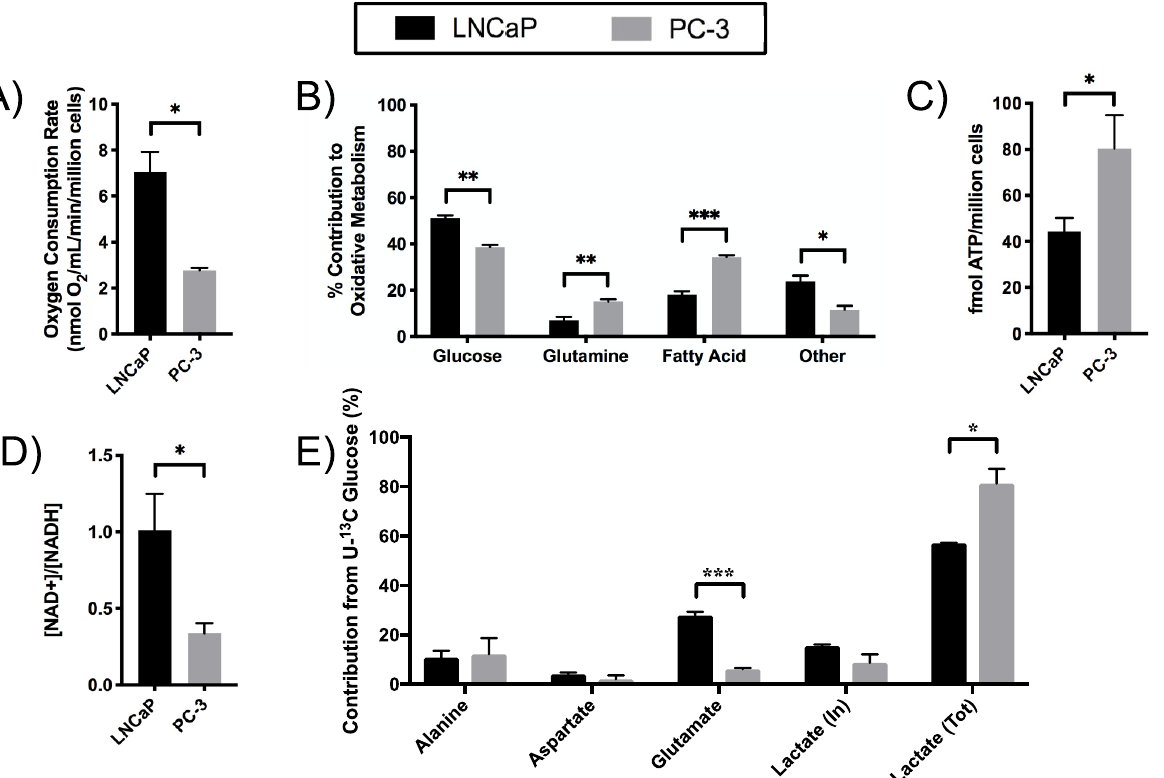
Figure 6. Cellular respiration and bioenergentics are altered in CRPC compared to ADPC. Oxygen consumption rate and relative substrate utilization for TCA metabolism of LNCaP and PC-3 cells. ( A ) Oxygen consumption rate of LNCaP and PC-3 cells was measured using a Clark-type O 2 electrode. ( B ) The relative contributions of glucose, long-chain fatty acids, and glutamine to the TCA cycle in PCa cells was assessed using the Seahorse XFe24 Mito Fuel Flex assay. Cellular bioenergetics of LNCaP and PC-3 cells was assessed based on ( C ) ATP content and ( D ) intracellular NAD + /NADH. ( E ) Relative mass contribution of 13 C-glucose to downstream metabolites. Lactate (in) refers to intracellular and (tot) refers to total of the intracellular and extracellular pools of 13 C labeled lactate. (* p < 0.05, ** p < 0.01, *** p < 0.001)